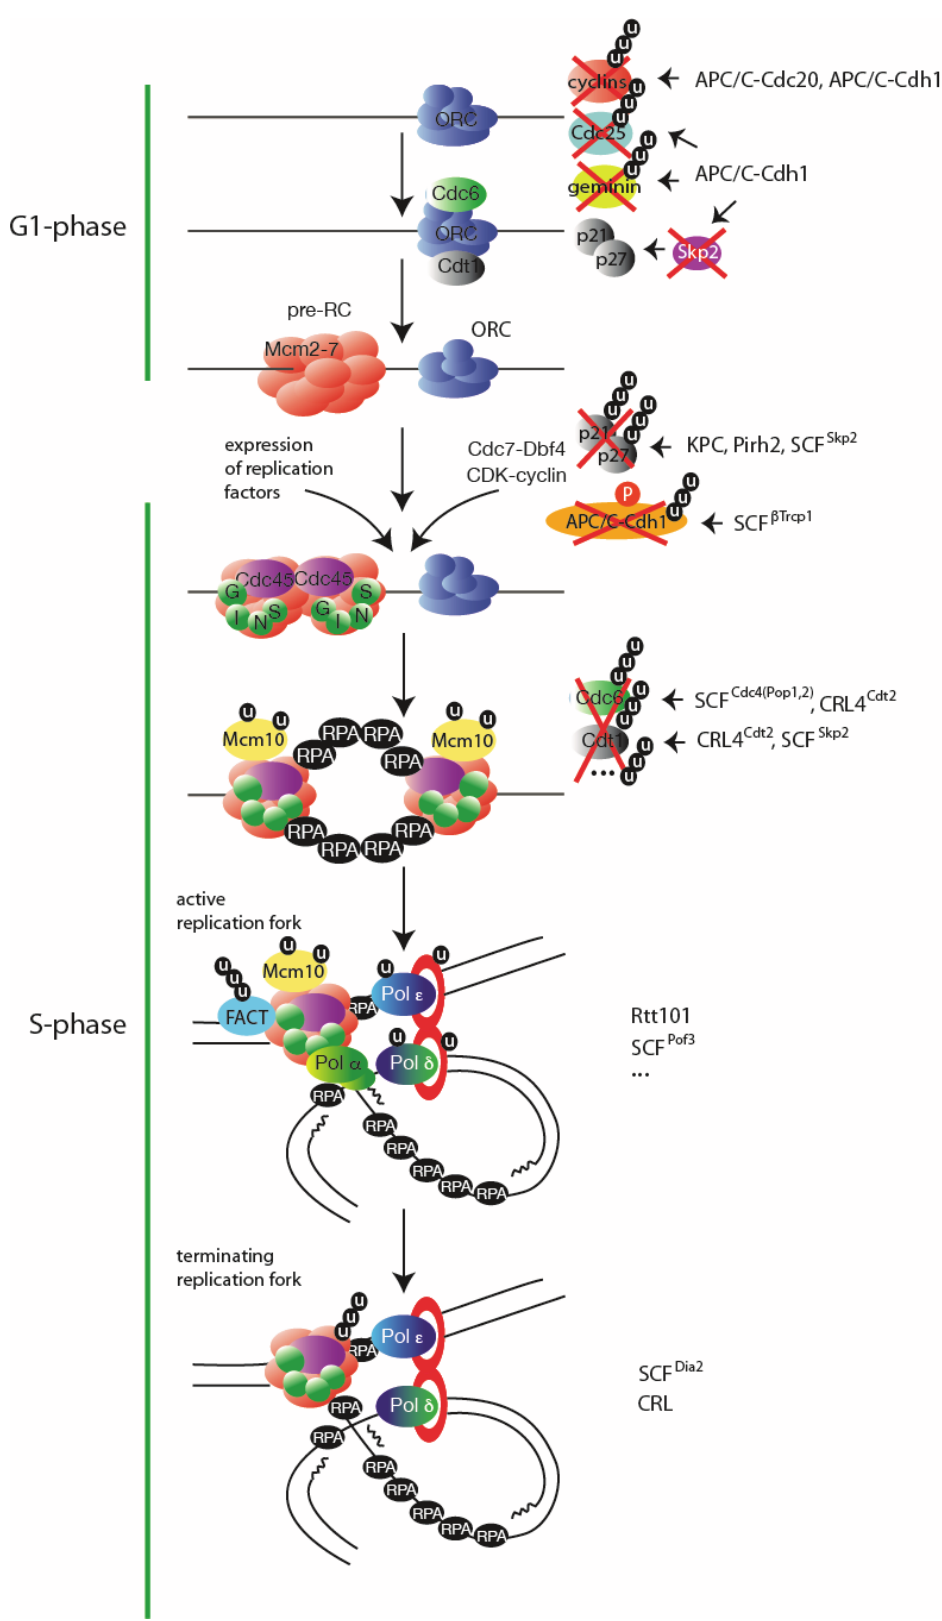
Figure 2. Ubiquitylation regulates every stage of eukaryotic DNA replication. A simplified view of steps in DNA replication with indicated major substrates of ubiquitylation regulation. On the right hand side the respective ubiquitin ligases are listed, if known. Further explanations can be found in the